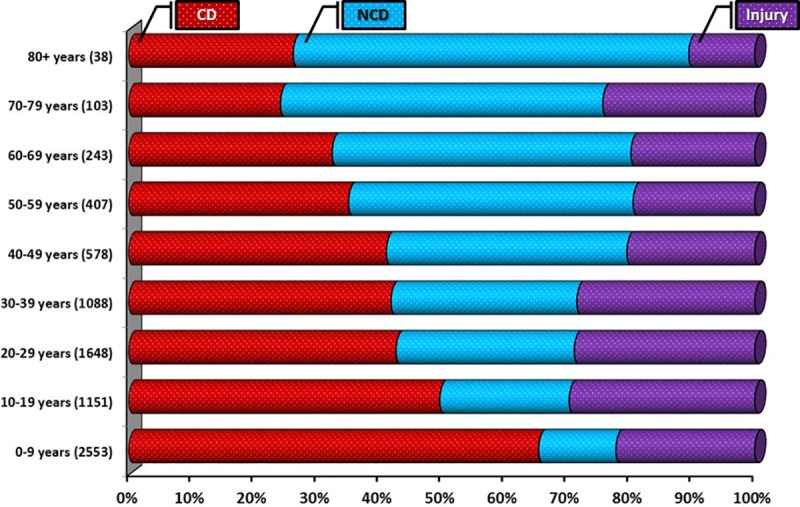
Pattern of CD, NCD and injury according to age profile.